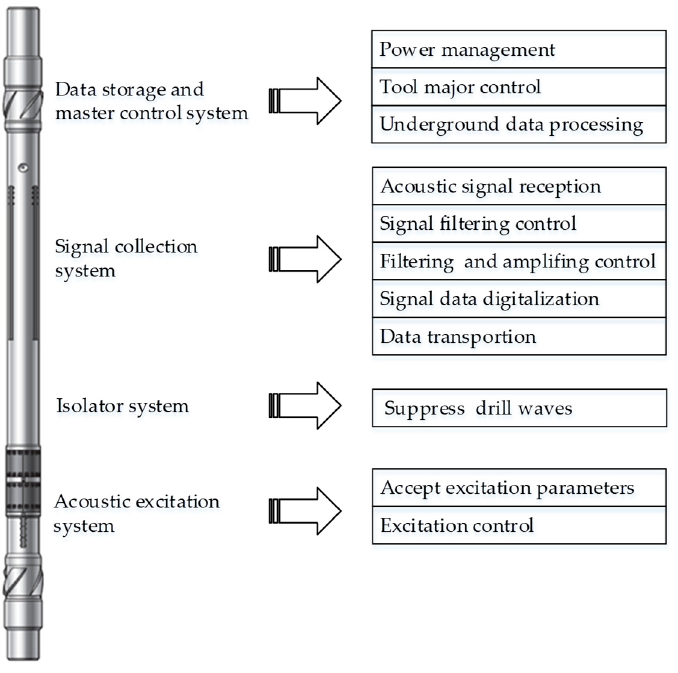
Figure 1. Schematic representation of the structure of the designed acoustic logging while drilling tool, and main functions of each part. tool, and main functions of each